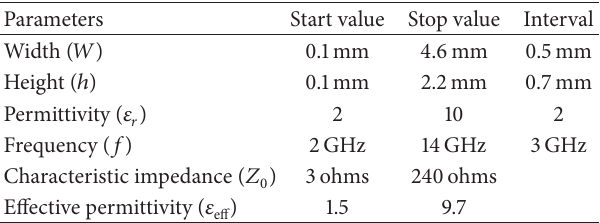
Figure 4: Cost effective 3D EM simulation-based Support Vector Microstrip Modeling. Table 1: The range of values for SVRM training data set for coarse model.